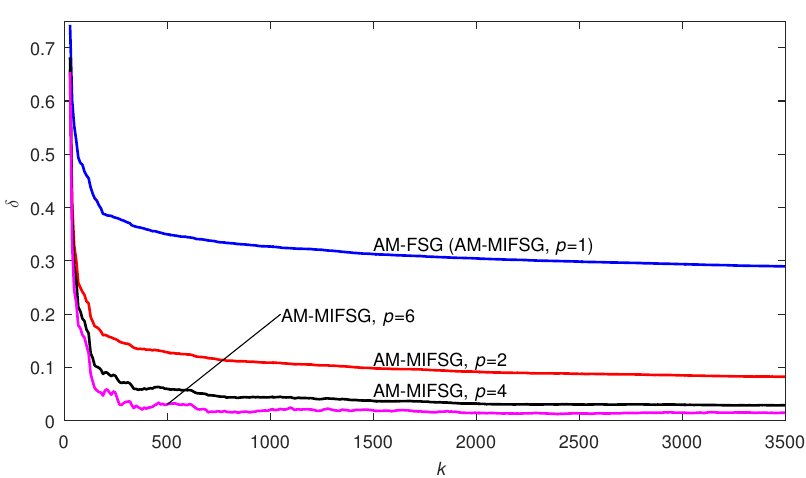
Figure 3. The AM-MIFSG estimation error δ versus k with p = 1, 2, 4 and 6. Table 1. The AM-MISG estimates and errors p = 1, 2, 4 and